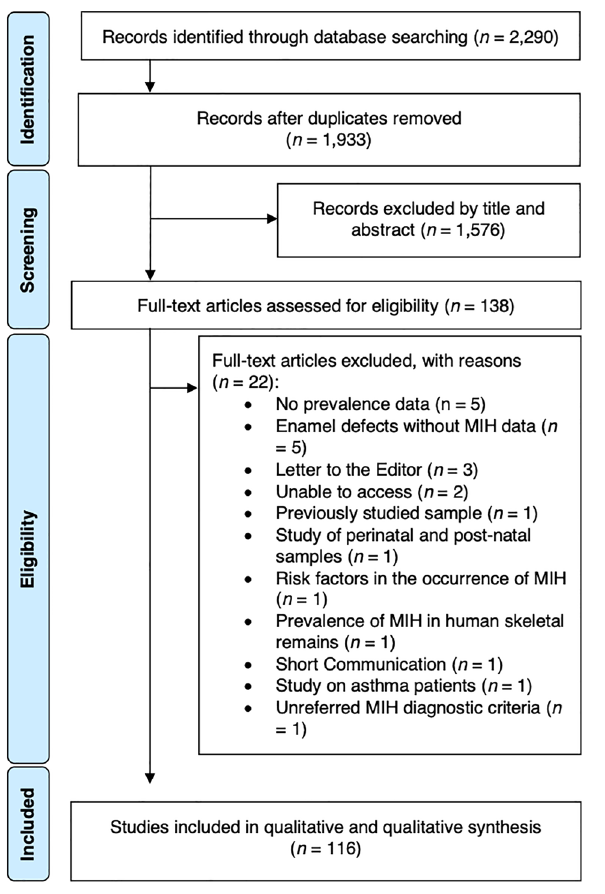
Figure 1. PRISMA